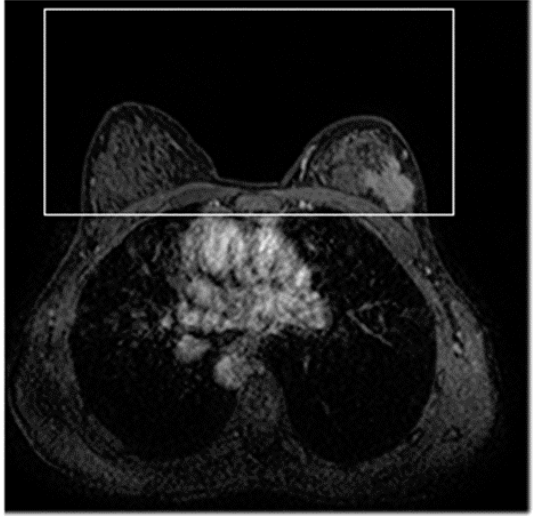
Figure 2. A single slice of the original image with the selected working area.